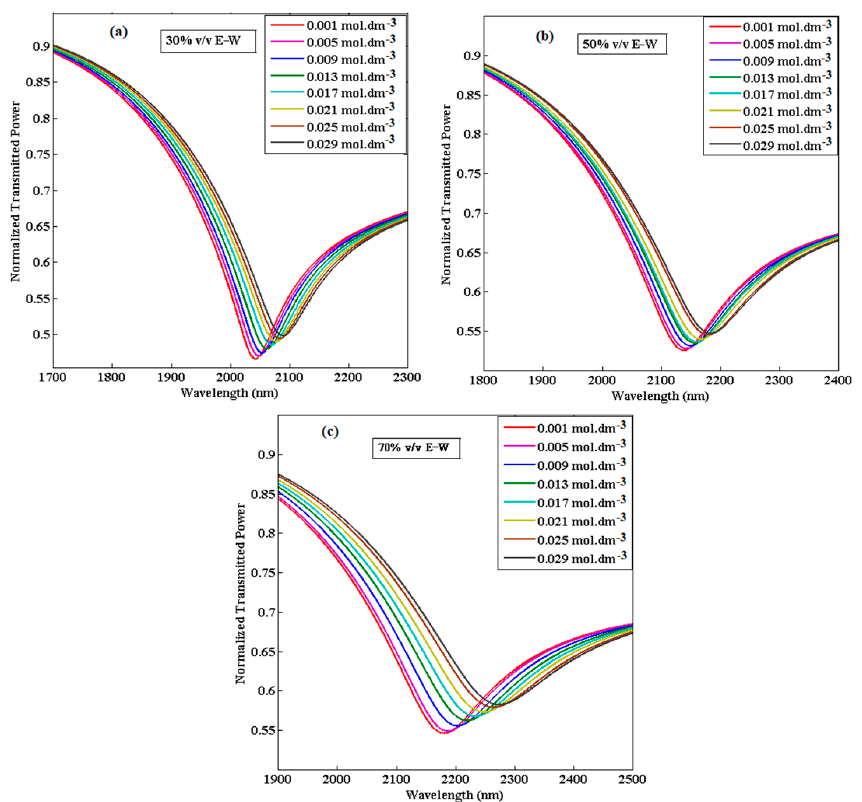
Figure 12. Transmitted LMR spectra (the first LMR curve) of the proposed ITO-coated U-shaped LMR sensor for the detection of ciprofloxacin having different concentrations and compositions ( a ) 30% v / v E–W mixture, ( b ) 50% v / v E–W mixture, and ( c ) 70% v / v E–W